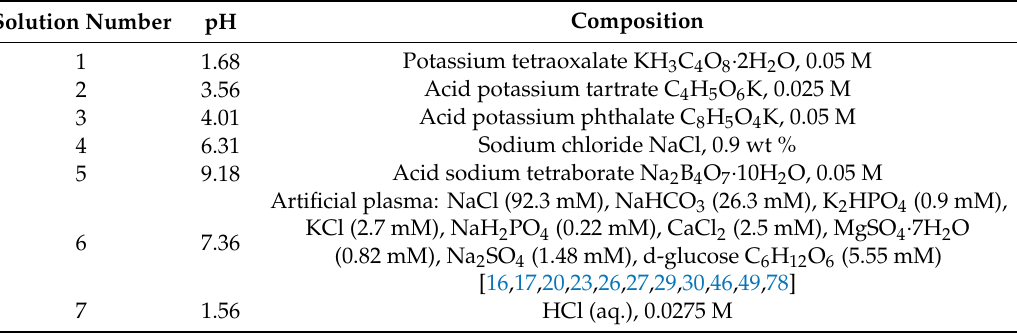
Table 1. pH and composition of the solutions used for immersion